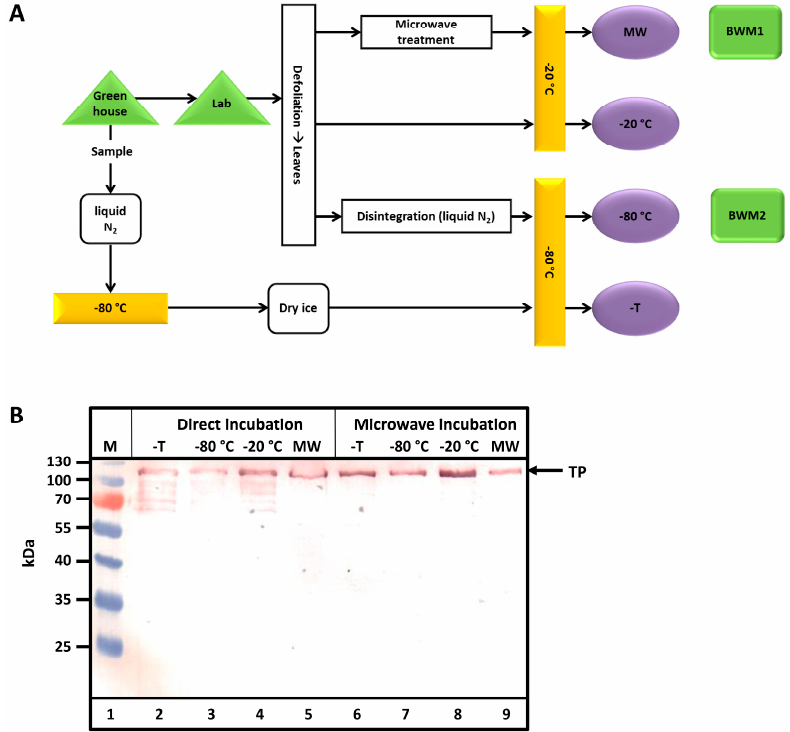
Figure 2. Prevention of post-harvest degradation of Q-MaSp1-100× ELP (TP) by microwave treatment.